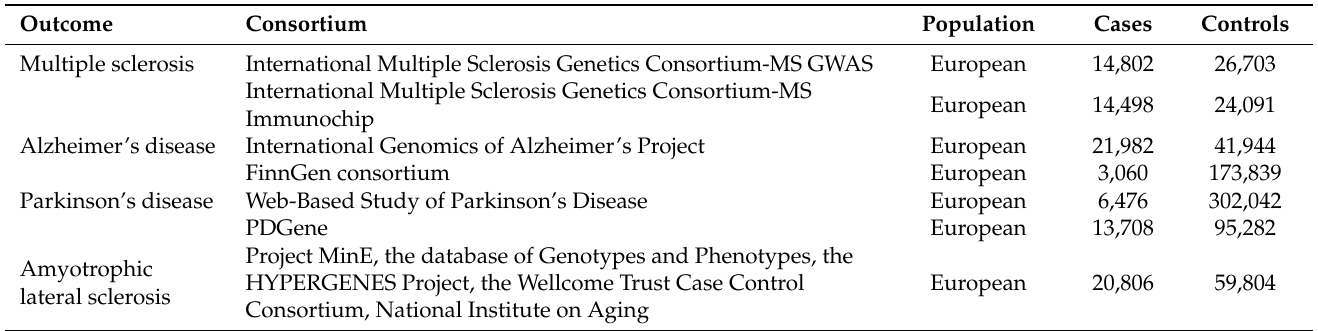
Table 1. Studies and datasets adopted in the present analyses.